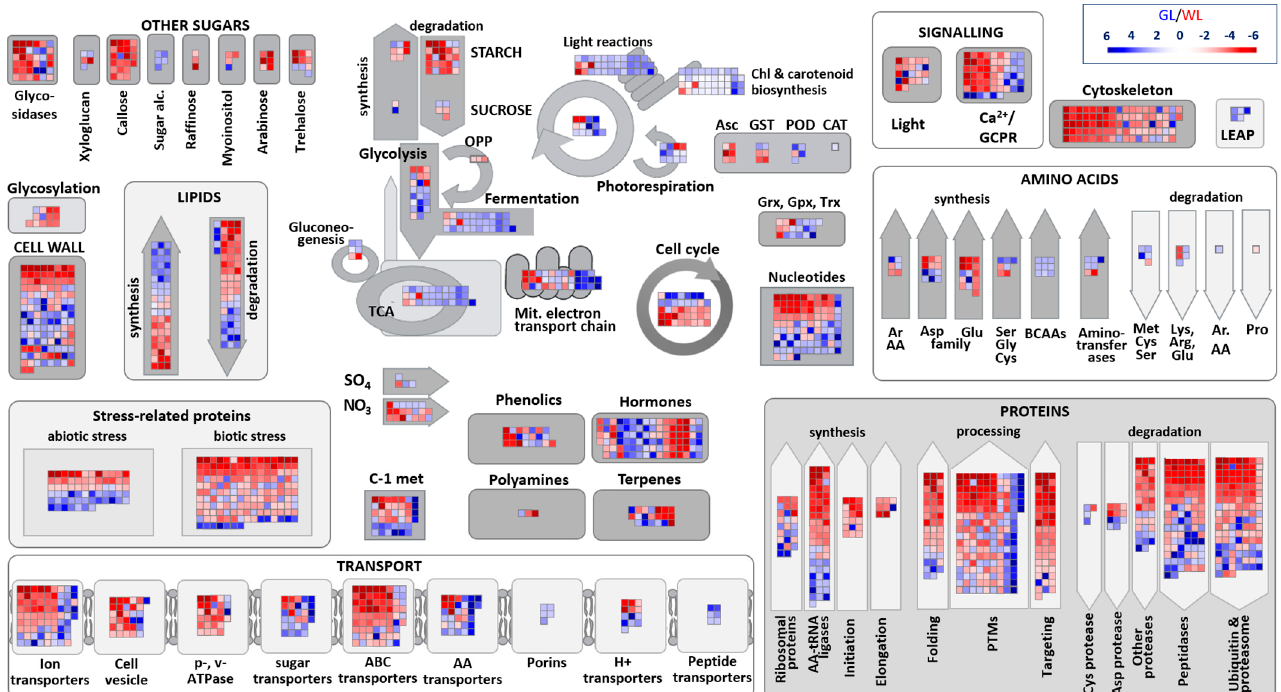
Figure 3. MapMan representation of DEGs in GL compared to WL of P. zonale manually mapped after TAIR mapping. Upregulated DEGs in GL are shown in blue (positive values), and upregulated DEGs in WL are shown in red (negative values). AAs, amino acids; ABC, ATP-binding cassette transporters; alc, alcohols; Asc, ascorbate; Ar, aromatic; BCAAs, branched-chain amino acids; C-1 met, C-1 metabolism; CAT, catalase; CHO, carbohydrates; GCPR, G-protein-coupled receptors; GSH, reduced glutathione; Grx, glutaredoxins; Gpx, glutathione peroxidases; GSTs, glutathione S - transferases; LEAP, late embryogenesis abundant protein; Mit, mitochondrial; OPP, oxidative pen- tose-phosphate pathway; POD, class III peroxidases; Prx, peroxiredoxins; PTMs, post-translational modifications; ox-red, oxidoreductases; RBPs, ribosome-binding proteins; TCA, tricarboxylic acid cycle; Trx, thioredoxins. Due to a large number of associated DEGs, DNA and RNA metabolism are not presented in this scheme.